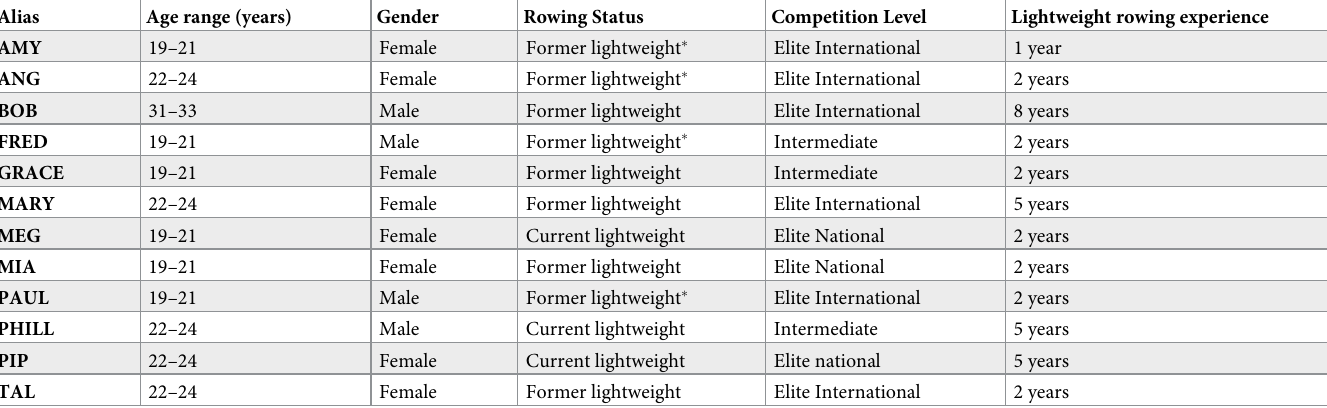
Table 1. Participant characteristics.